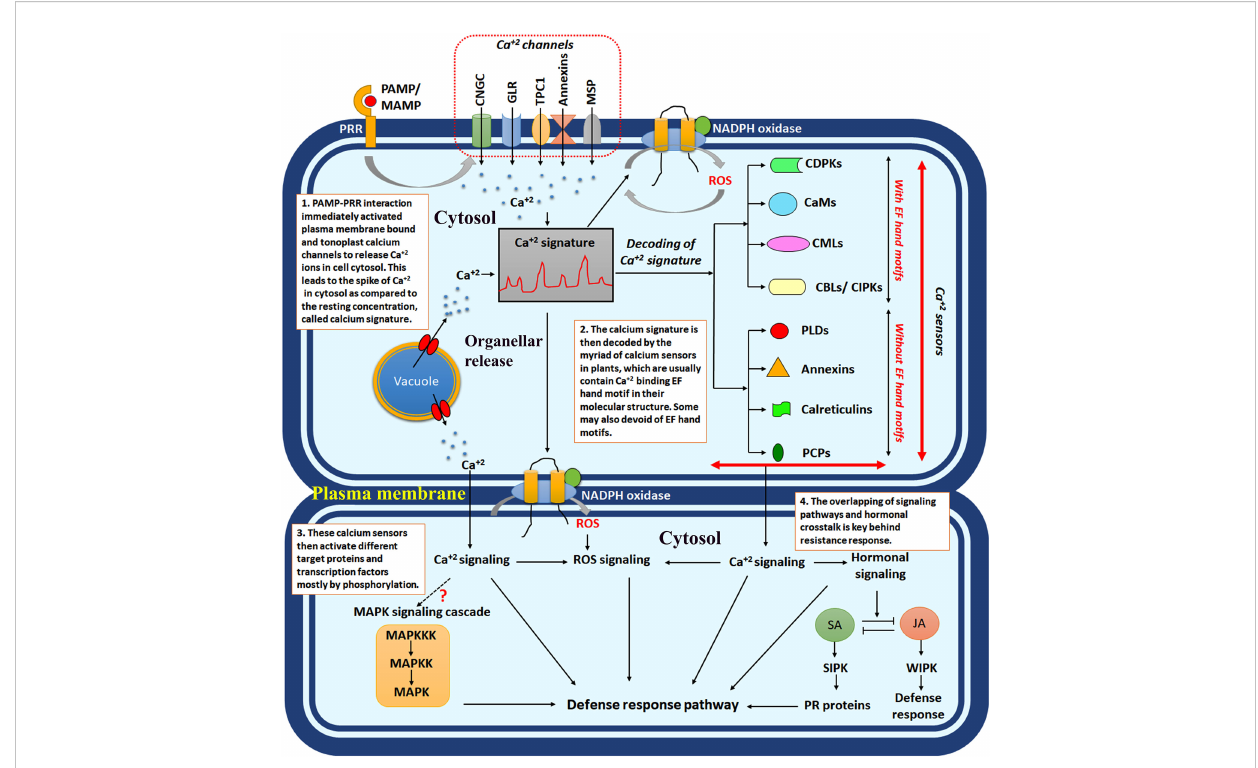
FIGURE 1 The schematic diagram showing intracellular calcium signalling in response to plant-microbe interaction. PAMP/MAMP, pathogen-associated molecular pattern/microbe-associated molecular pattern; PRR, pattern recognition receptors; CNGCs, cyclic nucleotide-gated channels; GLR, ionotropic glutamate receptors; TPC1, two-pore channel 1; MSP, mechanosensitive protein channels; CDPKs, calcium-dependent protein kinases; CaMs, calcium calmodulins; CMLs, CaM like proteins; CBLs, calcineurin B like proteins; SA, salicylic acid; JA, jasmonic acid; SIPK, salicylic acid induced protein kinase; WIPK, wound-induced protein kinase; ROS, reactive oxygen